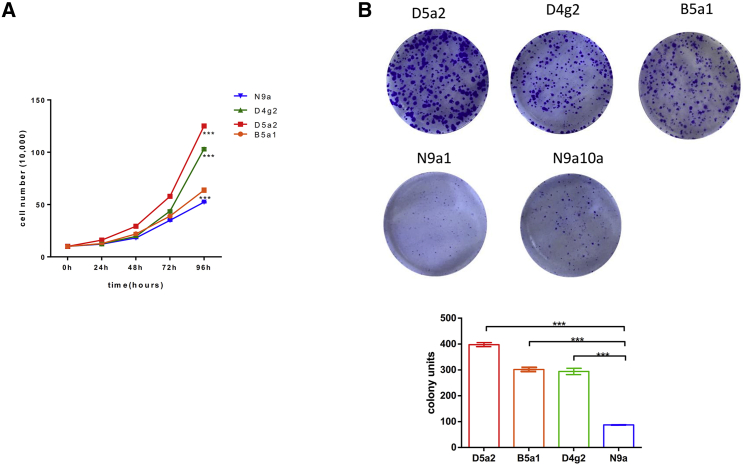
Haplogroup N9a Have Lower Tumorigenic Activity than Non-N9a (B5a1, D5a2, D4g2) Cybrids(A) Cell proliferation curve of N9a and non-N9a cybrids (n = 3). (B) Colony formation assay of N9a and non-N9a cybrids (n = 3). Data are presented by means ± SEM, and ***p < 0.001.